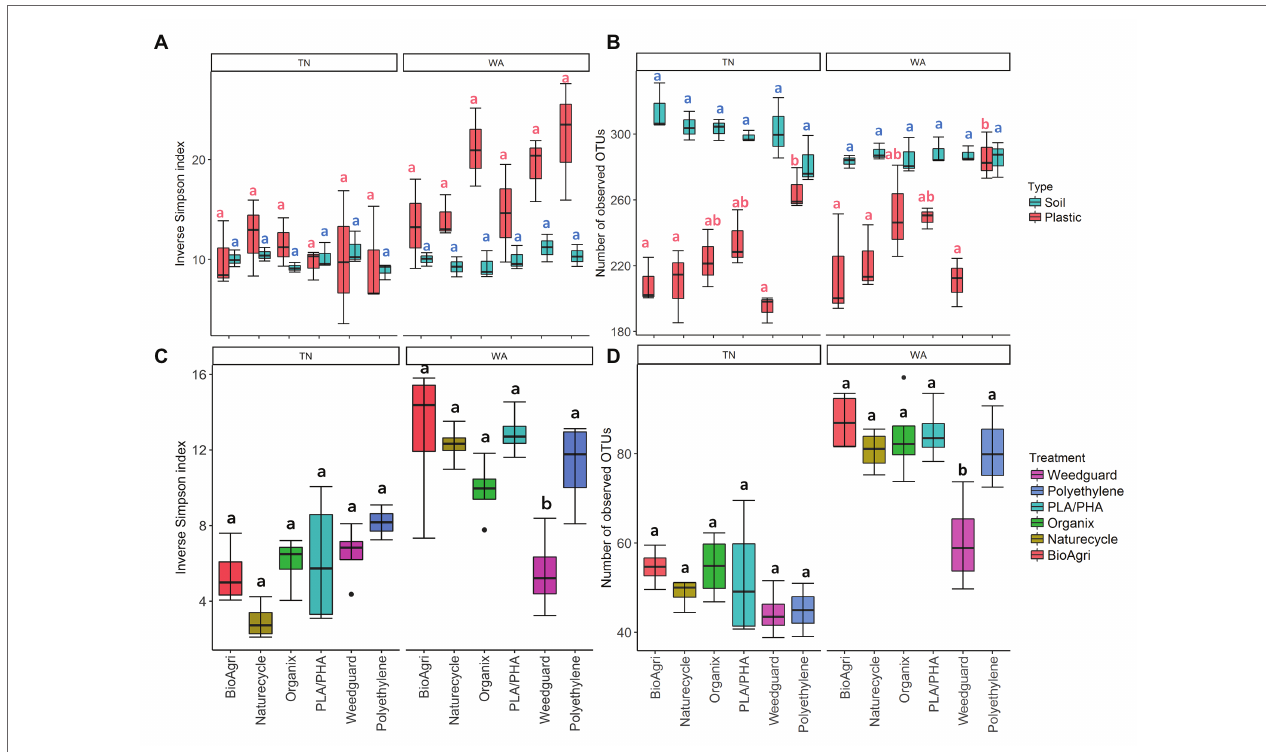
FIGURE 4 | (A) Diversity (inverse Simpson Index) and (B) richness (number of observed OTUs) of bacterial communities on agriculturally-weathered BDMs and bulk soil in TN and WA. (C) Diversity (inverse Simpson Index) and (D) richness (number of observed OTUs) of eukaryotic communities on agriculturally-weathered BDMs in TN and WA. The lower and upper hinges of the boxplots correspond to the 25th and 75th percentile and the middle of the box denotes the median at 50th percentile. Whiskers denote 1.5 times the inter-quartile range. Letters indicate Tukey post hoc results following a one-way ANOVA. All significances tested at α =